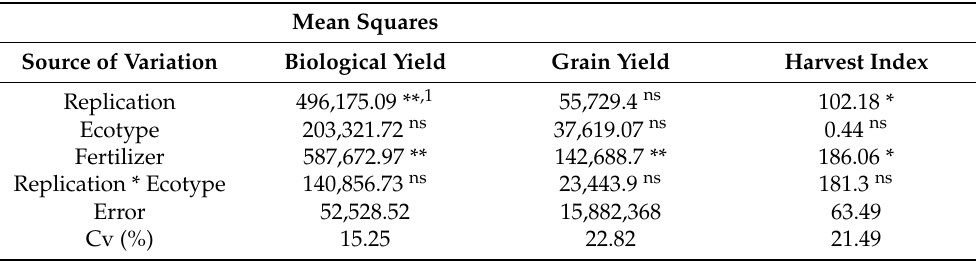
Table 1. Analysis of variance in the data for grain production traits of two dill ecotypes under chemical and biofertilizer treatments.